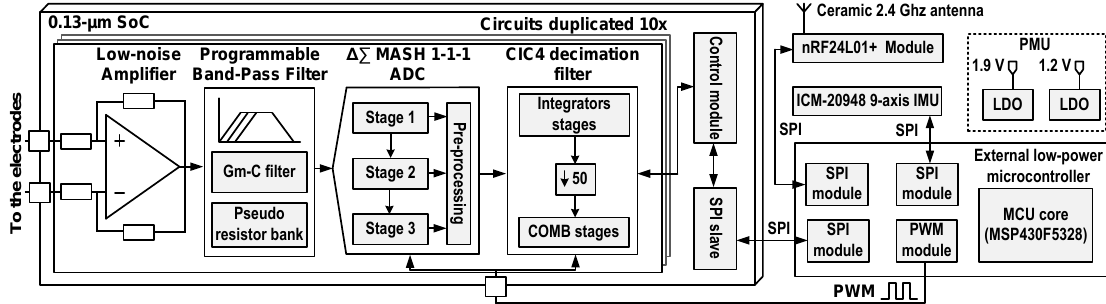
Figure 2. System-level concept of the multichannel wireless sEMG sensor: The sensor is built around a custom 0.13- µ m SoC that includes 10 × sEMG channels, each of which encompasses a bioamplifier, a ∆Σ analog-to-digital converter (ADC), and a 4th order decimation filter. The SoC, the nRF24L01+ low-power wireless transceiver, and the ICM-20948 9-axis IMU are interfaced with an MSP430F5328 low-power MCU.